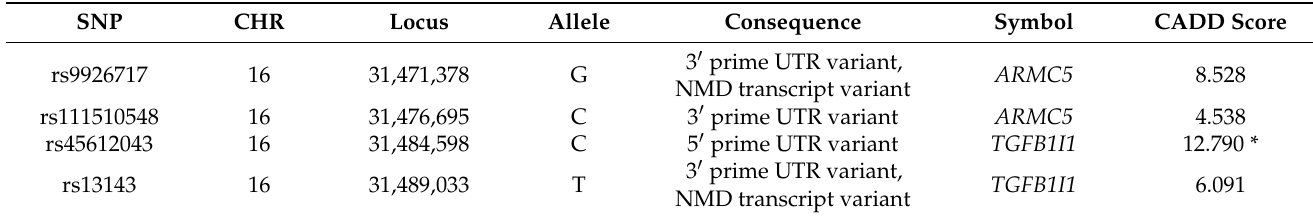
Table 3. 3 (cid:48) and 5 (cid:48) Prime UTR Variants within 25kb of SLC5A2 Gene